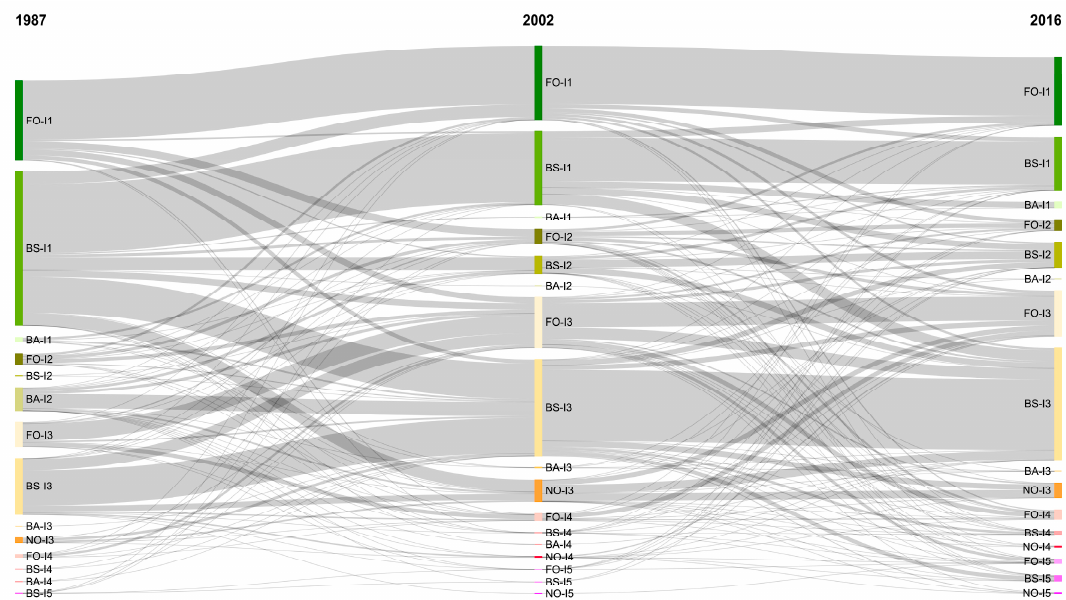
Figure 7. Sankey plot showing changes from one landscape type to another between 1987, 2002, and 2016. The colors and labels follow the scheme shown in Figure 2.